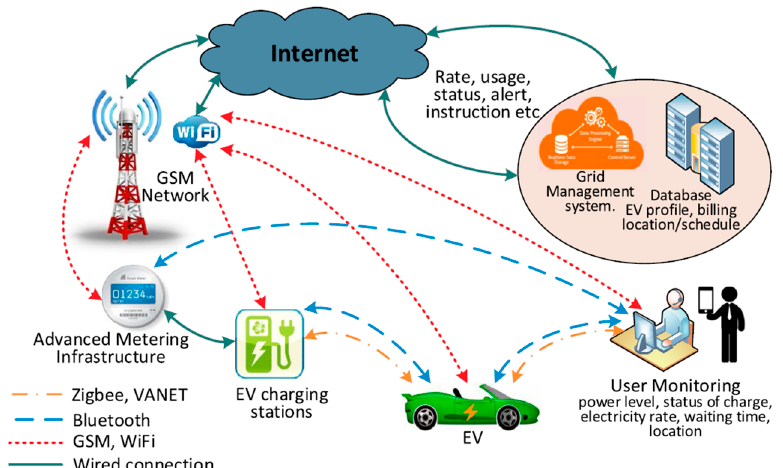
Figure 18. EV charging communication network [115].